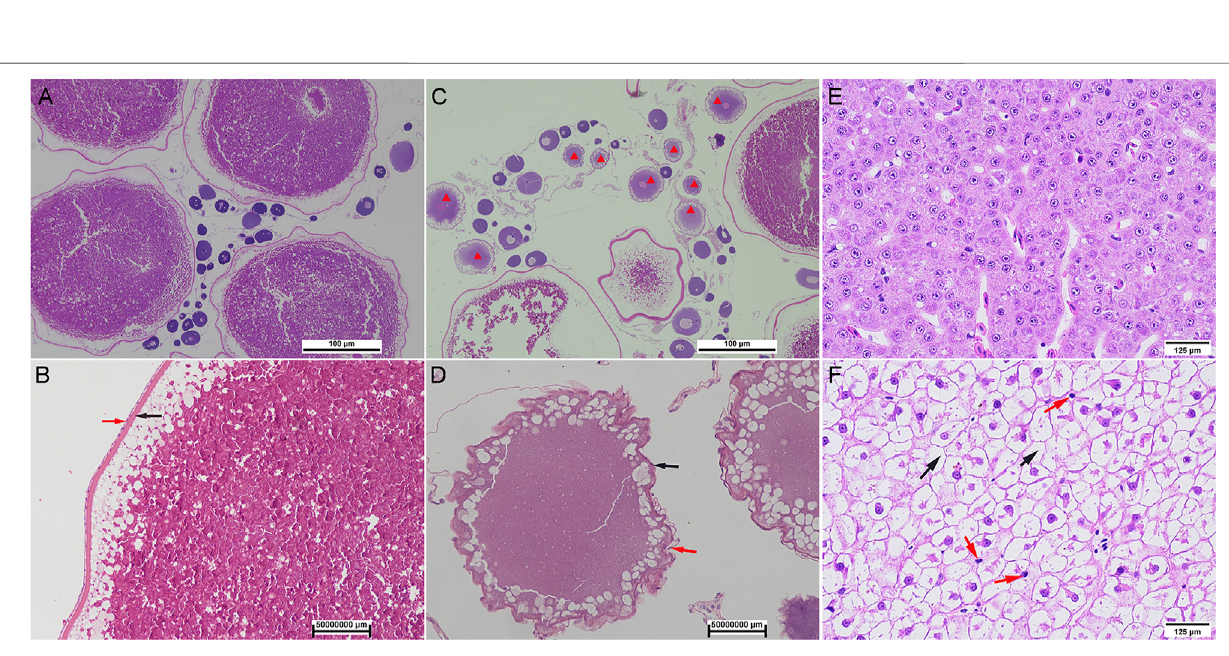
FIGURE2| Histologyofoocyteandliverinwildandcaptive-reared S.o ’ connori . (A,B) TheoocytesatstagesIVinovariesofwild S.o ’ connori . (C,D) Theoocytesat stages IV in ovaries of captive-reared S. o ’ connori . Red star: atresia oocytes; Black arrow: chorion; Red arrow: follicular cell layer. The liver in wild (E) and captive-reared (F) S. o ’ connori . Black arrow: lique fi ed